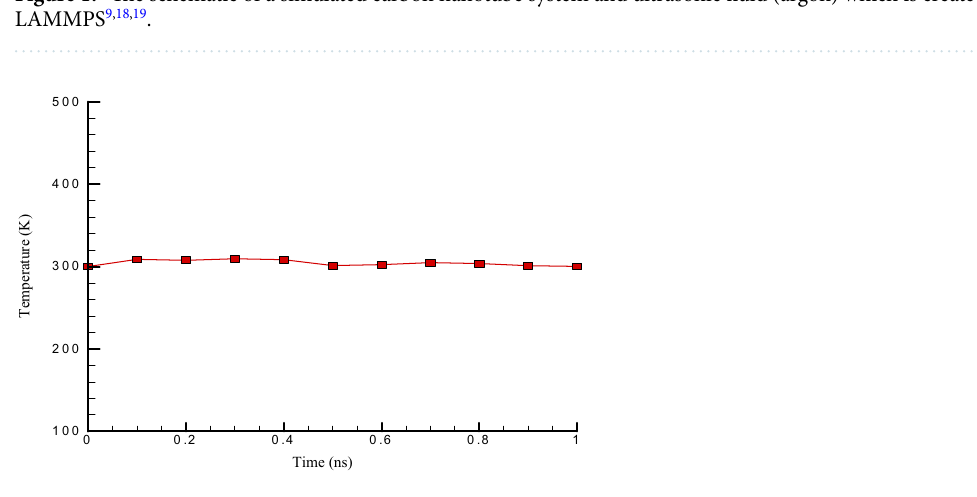
Figure 2. The Temperature changes vs. time in the existence of carbon nanotubes (7 and 7) with a length of 5 nm at the initial temperature (300